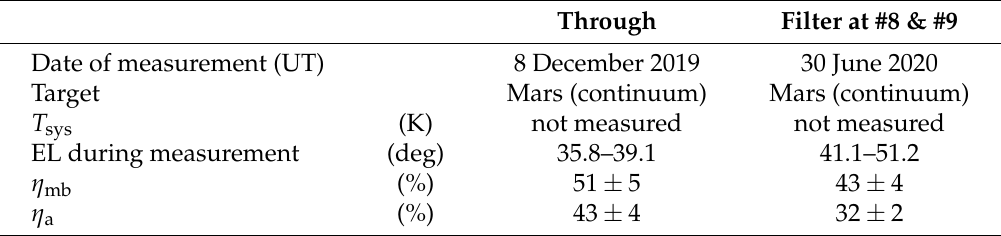
Table 6. Summary and results of η mb and η a measurements in the 86-GHz observing system. Through Filter at #8 &